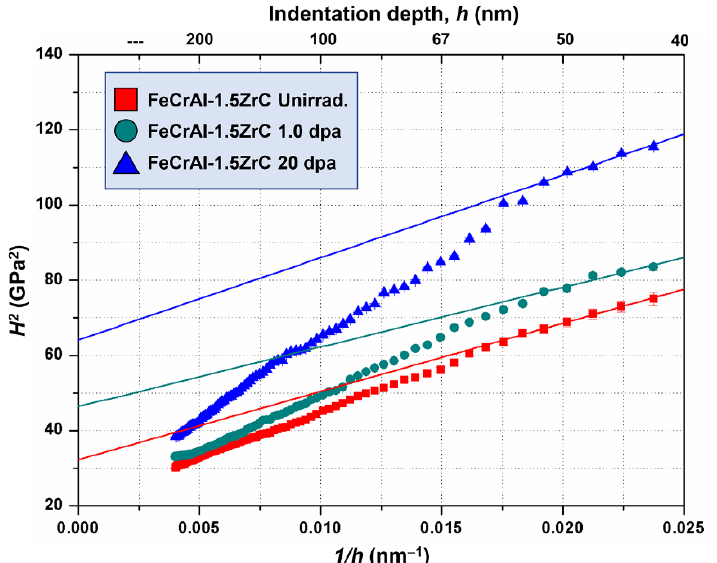
Figure 4. Profiles of H 2 and h − 1 for specimens at different irradiation doses. The red, green and blue lines represent unirradiated, 1.0 dpa and 20 dpa specimens,